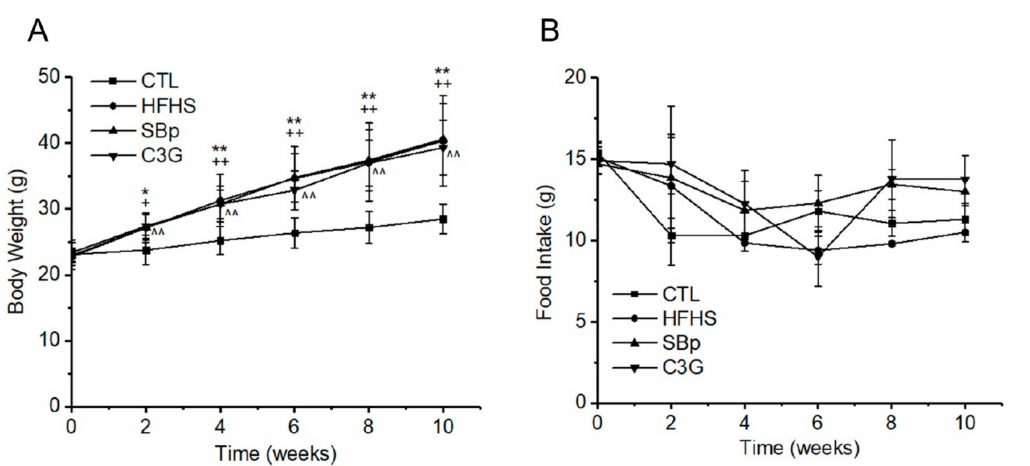
Figure 1. E ff ects of Cyanidin-3-glucoside (C3G) supplemented in a high fat-high sucrose (HFHS) diet on the body weight and food intake of mice. Male C57 BL / J6 mice (6 weeks of age) were randomized into 4 groups and received the following diets for 11 weeks: control (CTL) group: control diet, HFHS group: HFHS diet, Saskatoon berry powder (SBp) group: SBp (8.0 g / kg / day) supplemented in the HFHS diet, C3G group: C3G (7.2 mg / kg / day) supplemented in the HFHS diet. Body weights and food intake